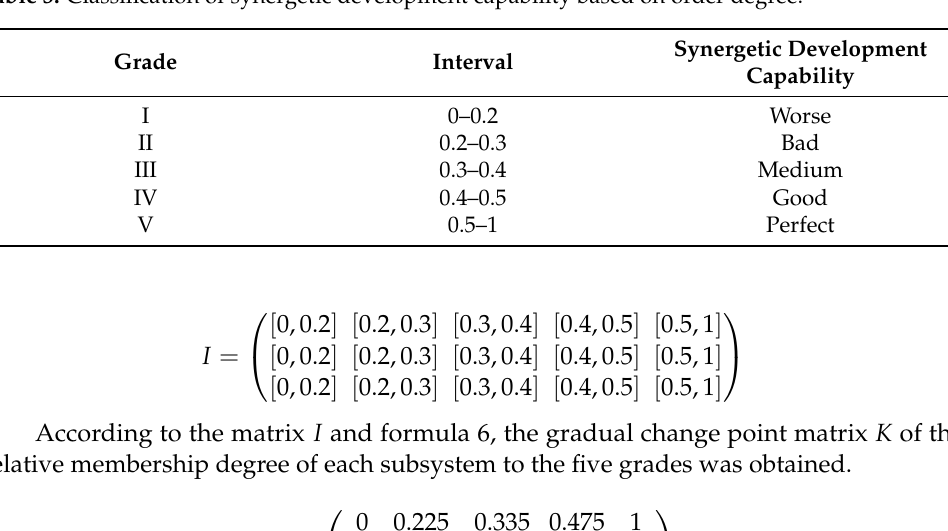
Table 3. Classification of synergetic development capability based on order degree.